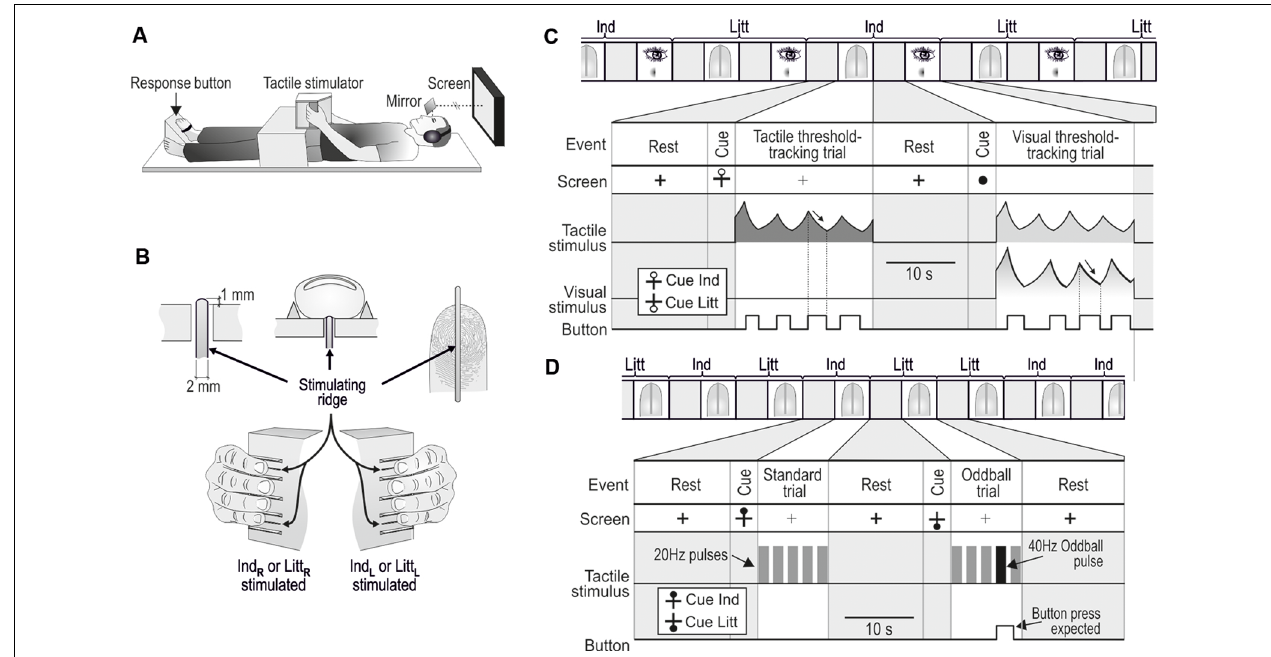
FIGURE 1 | Apparatus and tasks in the MR scanner. (A) With either the left of the right hand, the participants grasped the box-shaped tactile stimulator anchored to a wooden frame extending above their hips. The big toe of the contralateral foot operated the response button. The participants could view a computer screen via mirrors. (B) Either the tip of the index (Ind) or the little (Litt) finger was stimulated via perpendicular movements of ridges protruding above the surface of the box. Ind L , Litt L ,and Ind R ,Litt R refer to left- and right-hand fingers, respectively. (C) One of 24 paired tactile and visual threshold-tracking trials consecutively performed during a scanning session involving unilateral index (Ind) and little (Litt) finger stimulation. The stimulus in the tactile trial (represented as sinusoidal RMS value) was replayed during the following visual trial. Participants pressed the response button when perceiving the stimulus, which caused the stimulus intensity to decrease (arrows), and when the sensation vanished, participants released the button, which caused the intensity to increase. (D) Two out of 20 tactile oddball-detection trials consecutively performed during a scanning session including index (Ind) and little (Litt) finger stimulation. Standard trials contained five 1.5 s pulses with 20 Hz stimulation and in oddball trials, one of the 20 Hz pulses was replaced with a 40 Hz pulse as shown in the second trial illustrated. The participants pressed the response button when perceiving the deviant pulse. (C,D) During rest periods between trials, a black cross was shown on the screen. A circle that appeared 3–4.5 s before the start of a tactile trial cued the participants about the upcoming trial. The location of the circle either at the top or bottom of the cross indicated that stimuli will occur at the index or the little finger, respectively. The cue for an upcoming visual trial was a filled circle that substituted the cross. Figure is modified, with permission from Nordmark et al. (2012) published by the MIT